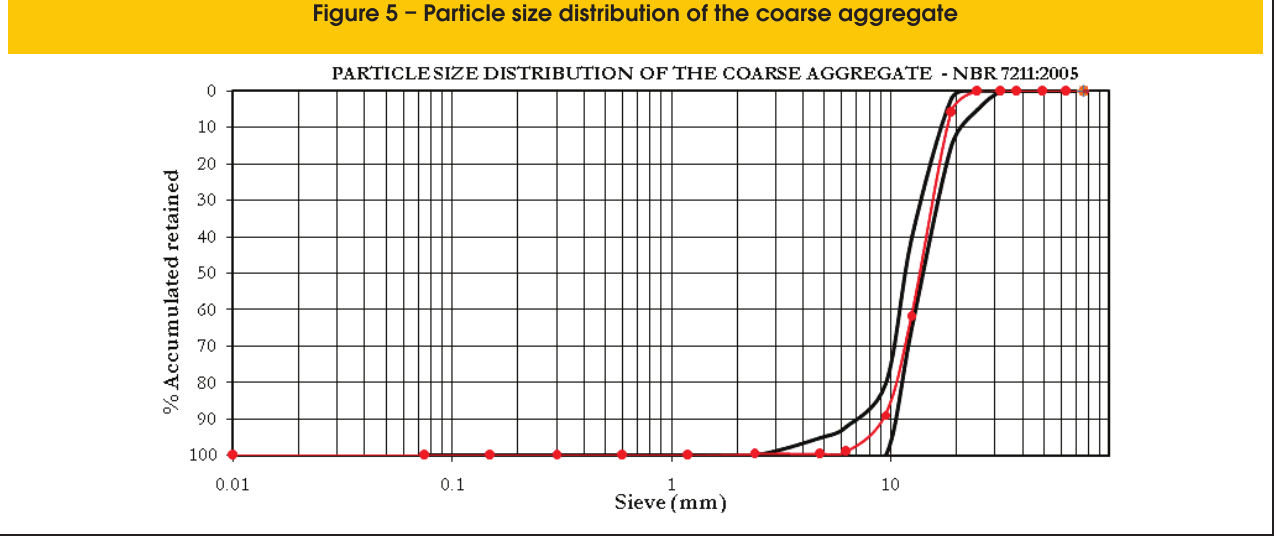
Figure 5 – Particle size distribution of the coarse